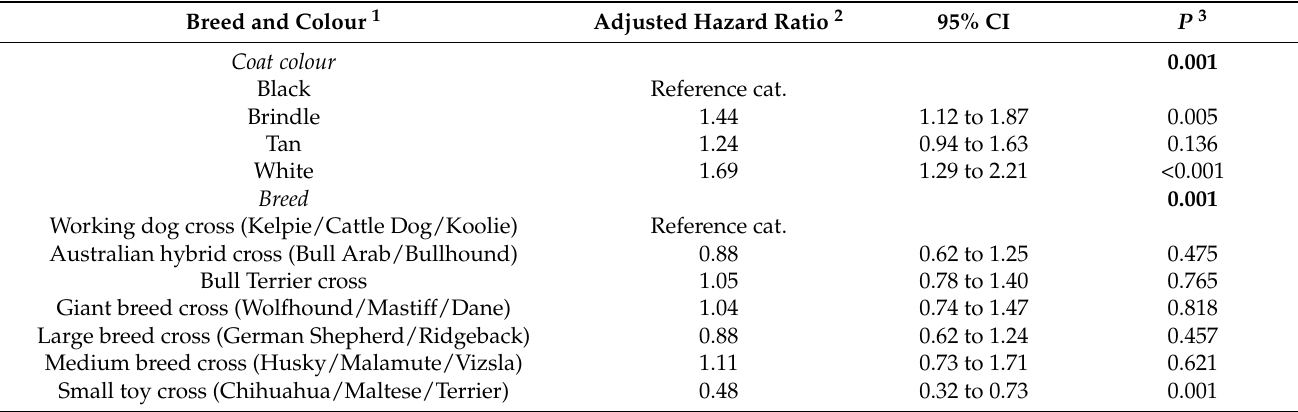
Table 6. Hazard ratios for dog coat colour and breed adjusted for each other on time-to-readmission to RSPCA Queensland for dogs adopted from RSPCA Queensland in 2019 and 2020.